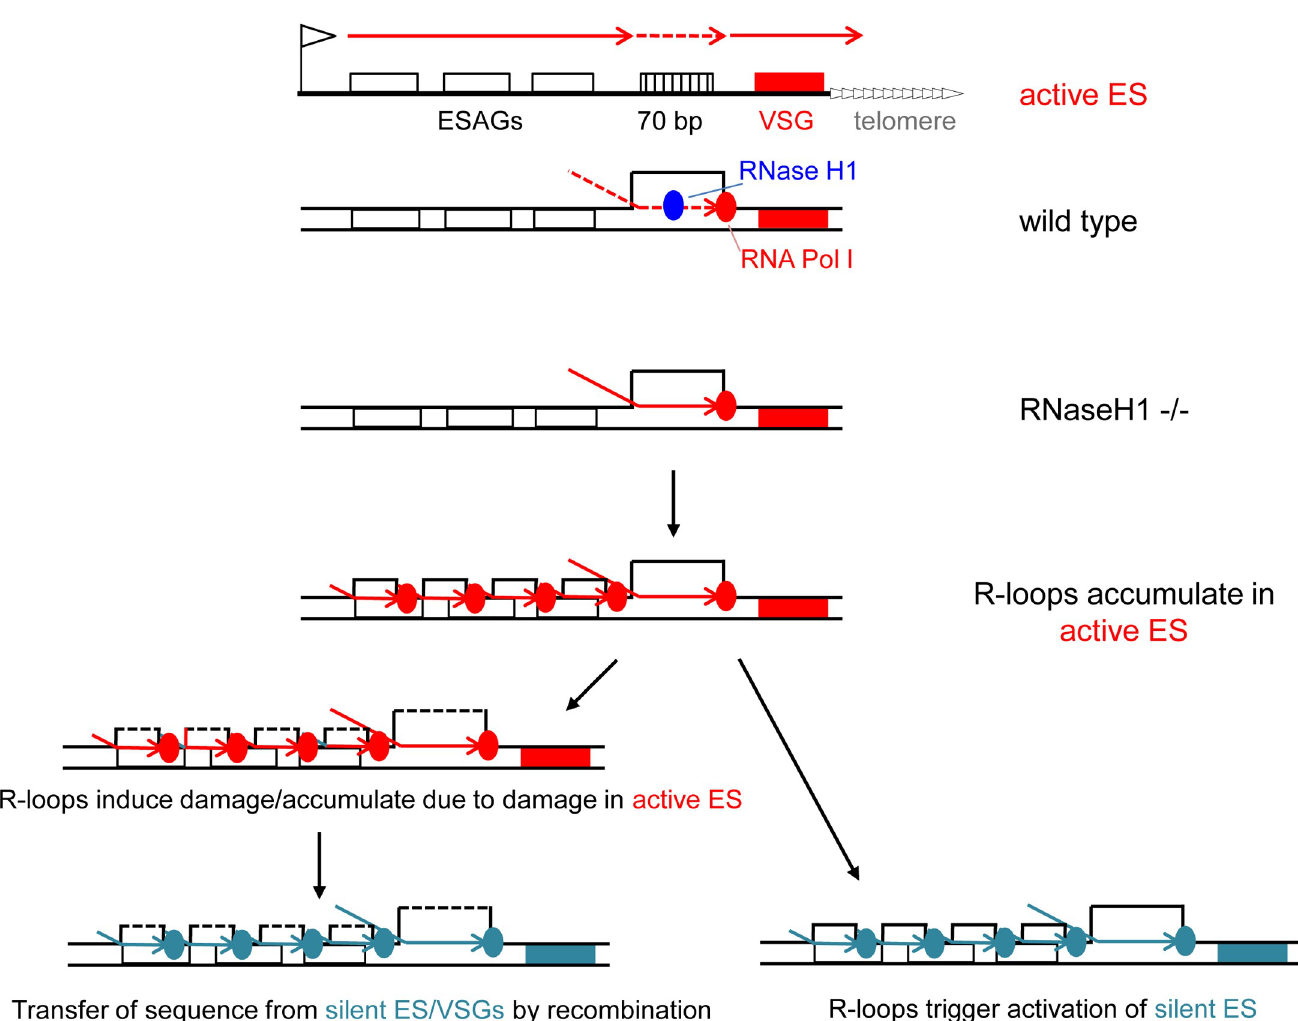
Fig 5. Models of R loop accumulation and resolution in the VSG expression sites of wild type and RNase H1 mutant T . brucei bloodstream form cells. The topmost diagram summarises the structure of and transcription across (red arrows) the active VSG expression site (ES, black line), including key features: telomere repeats (white arrows), the VSG gene (red box), 70 bp repeats (hatched box), ESAG genes (white boxes) and the promoter (flag). In the active ES transcription by RNA Polymerase (Pol) I must occur at high levels in order to generate sufficient VSG to form a dense surface coat. Pol I (red circle) passage is slowed when traversing the 70 bp repeats (dotted arrow), leading to the formation of R loops (DNA-RNA hybrid and extruded single strand DNA) that RNase H1 (blue circle) resolves to allow continued transcription. In TbRNaseH1 null mutants (-/-) R loops accumulate in the 70 bp repeats, obstructing transcription and leading to upstream RNA Pol I stalls and the formation of R loops across the length of the ES. Two outcomes of can then occur. In the first, reduced expression of the active ES and VSG is lethal, allowing selection for cells that have activated a distinct ES and VSG (green box). The lack of R-loop resolution by TbRNaseH1 in this site then results in R-loop accumulation and selection for activation of further ES (not shown). In the second outcome, R loops in the active ES lead to, or result from DNA damage, which is then repaired by homologous recombination, resulting in the transfer of sequence (e.g. VSG s, ESAG s) from the silent archive, including the silent ES, into the active